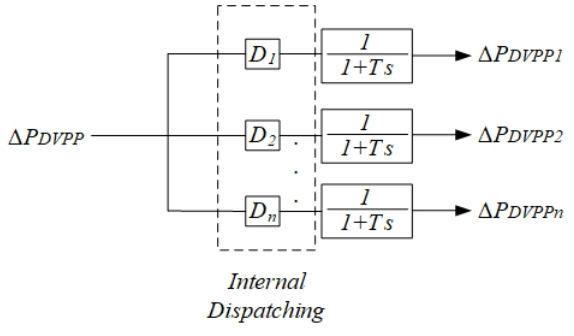
Figure 6. Internal dispatching of the DVPP for participation to the SFC.